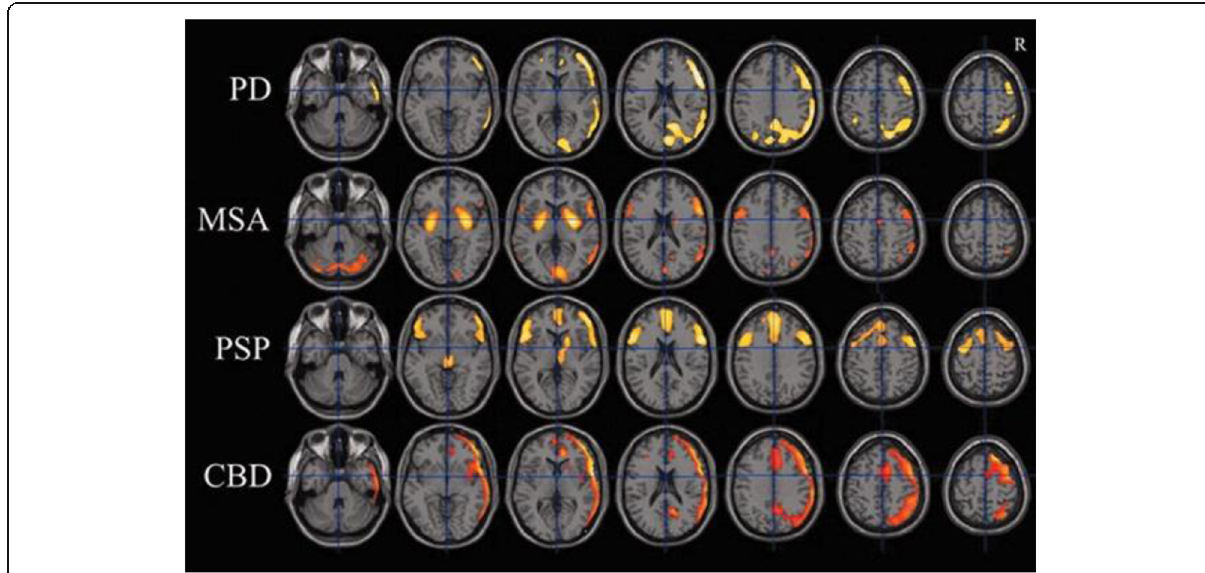
Fig. 2 The administration of 18 FDG-PET for the diagnosis of Parkinson ’ s and degenerative parkinsonism disorders. Consequences of the between- group statistical parametric mapping analysis for each diagnostic category shown in the vertical axis as follows: Parkinson ’ s disease (PD), multiple system atrophy (MSA), progressive supranuclear palsy (PSP), and corticobasal degeneration (CBD), vs. healthy controls. The red and yellow colors highlighted regions superimposed on normal T 1 -weighted MR templates showing areas with significantly reduced FDG uptake relative to the global mean